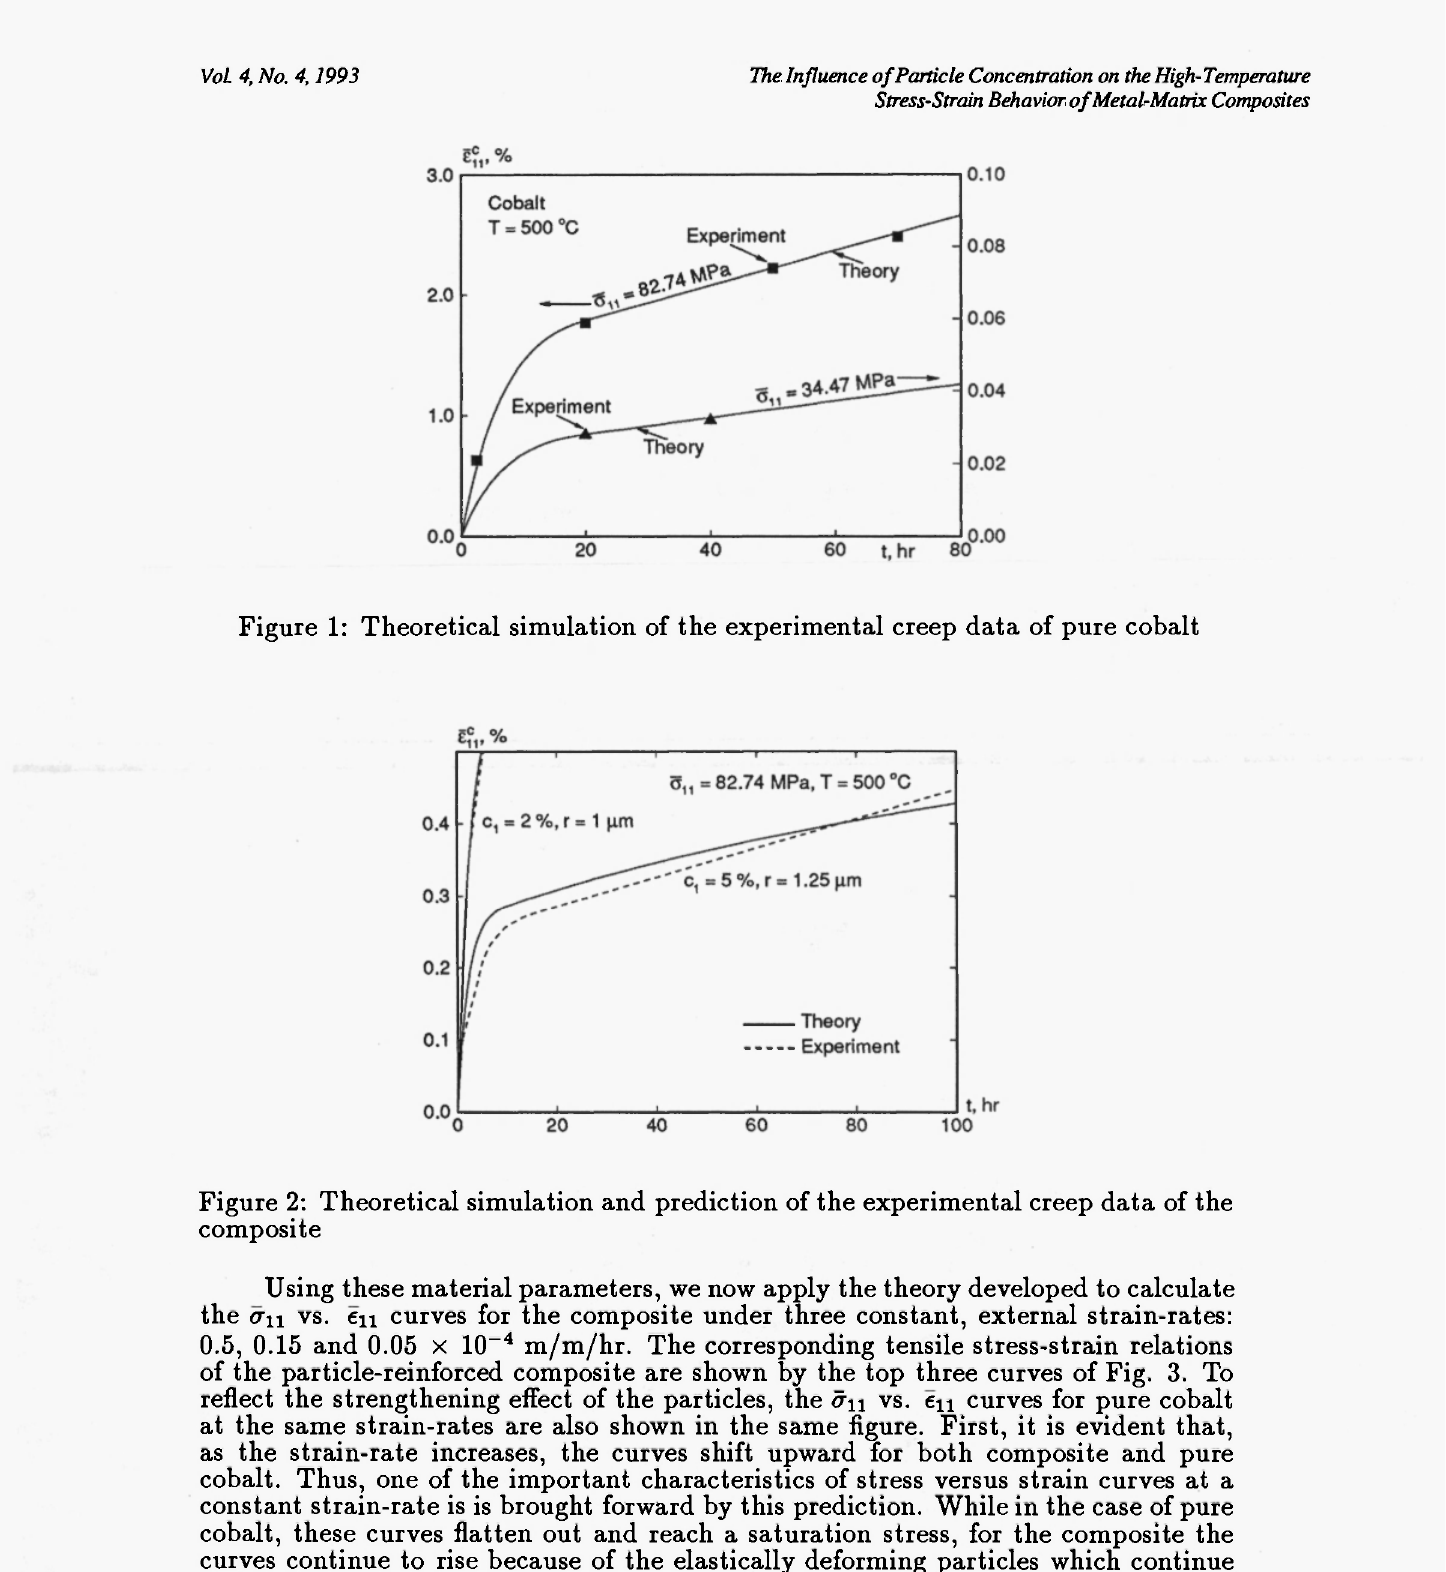
Figure 2: Theoretical simulation and prediction of the experimental creep data of the